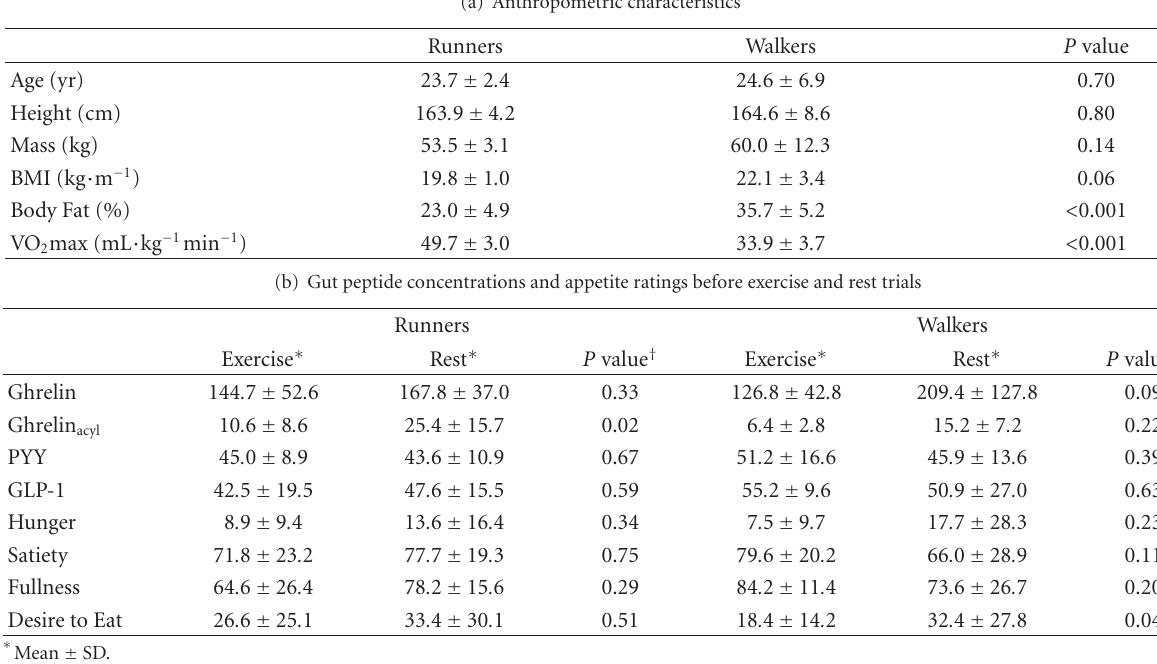
Table 2. Runners ran at an average pace of 2 . 9 ± 0 . 18